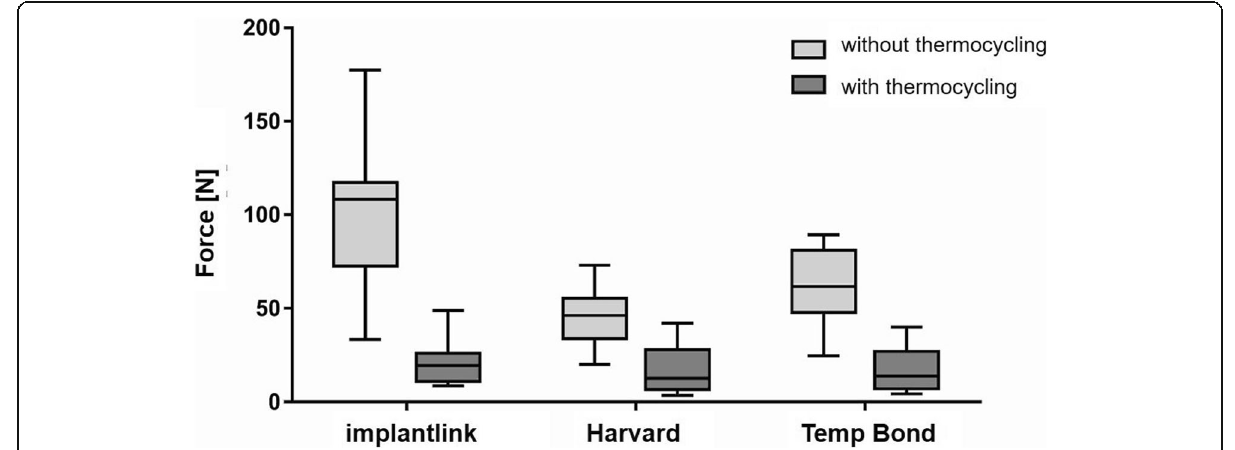
Fig. 5 Decementation load for the three tested cements (mean values with standard